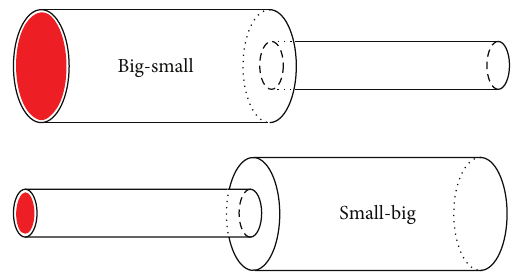
Figure 3: Linear combination of pores with different size (length: 1mm; big diameter: 4𝐸 − 3 mm; small diameter: 2𝐸 − 3 mm; red is the inlet area).